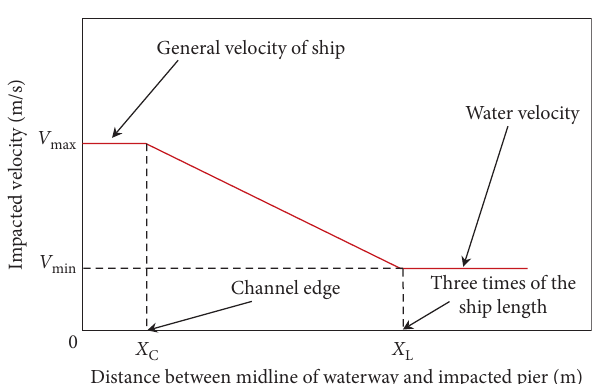
Figure 6: Determination of impacted velocity based on